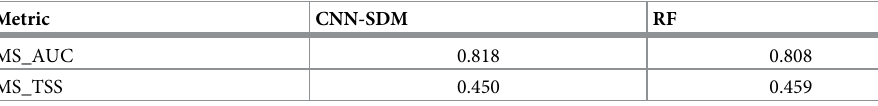
Table 2. CNN-SDM and RF evaluations with AUC and